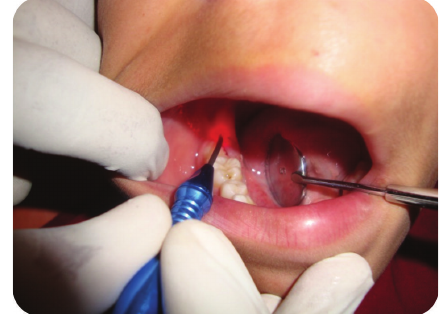
Figure 3: Excision of the pericoronal flap with diode laser.